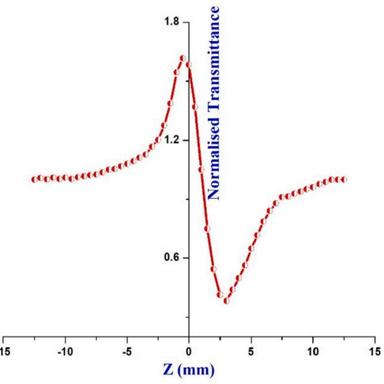
Z-Scan Transmittance curve for closed aperture.